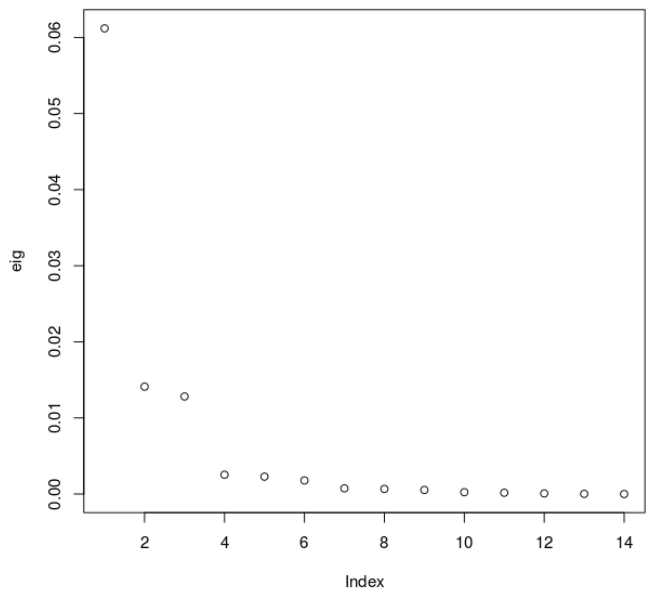
Figure A1. Scree plot of the eigenvalues calculated in our MCA. The y-axis shows the range in the values of our generated eigenvalues. The x-axis shows each dimension in order of the magnitude of its eigenvalue. Table A1. List of dimensions, related eigenvalues, the dimensions’ explained variance and deviation. Dimension No.